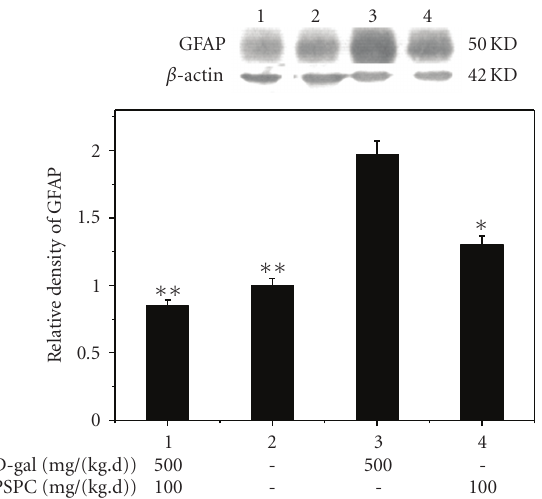
Figure 6: Western blot analysis of the expression level of GFAP protein in mouse brain ( n = 3). Data are averages from three independent experiments. Each value is the means ± SEM ∗ P < . 05, ∗∗ P < . 01, ∗∗∗ P < . 001 versus D-gal